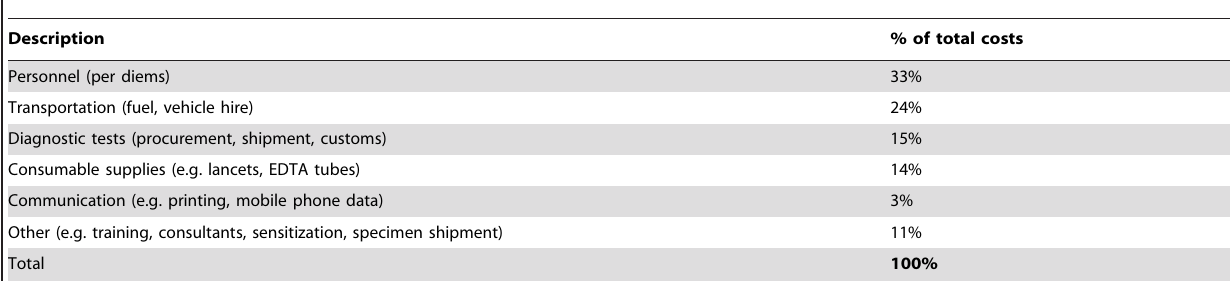
Table 12. Allocation of TAS costs by spending